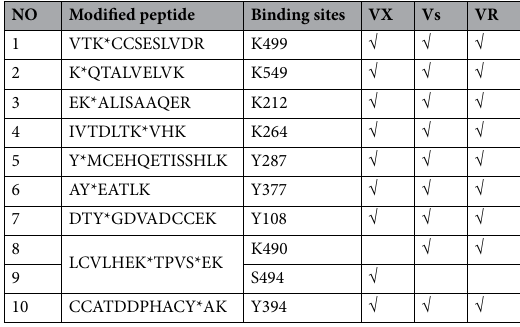
Table 3. Phosphonylated sites modified by V-type agents in rabbit albumin.